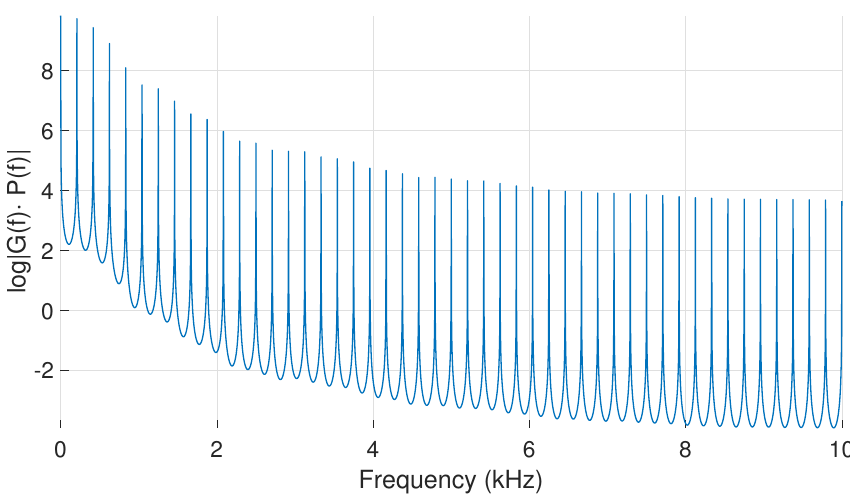
Figure 2. Spectrum of periodic input P ( z ) multiplied in the frequency domain by Rosenberg model G ( z ) , which corresponds to an ARMA model of the glottal source ( f 0 = 210 Hz).